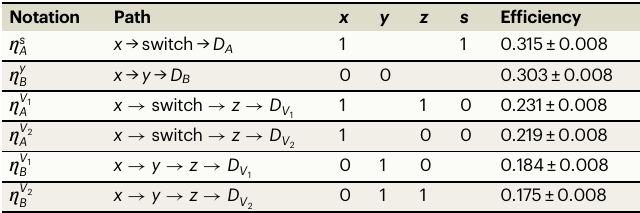
Table 1 | List of notations and measured values for the ef fi ciencies corresponding to the different paths involved in the